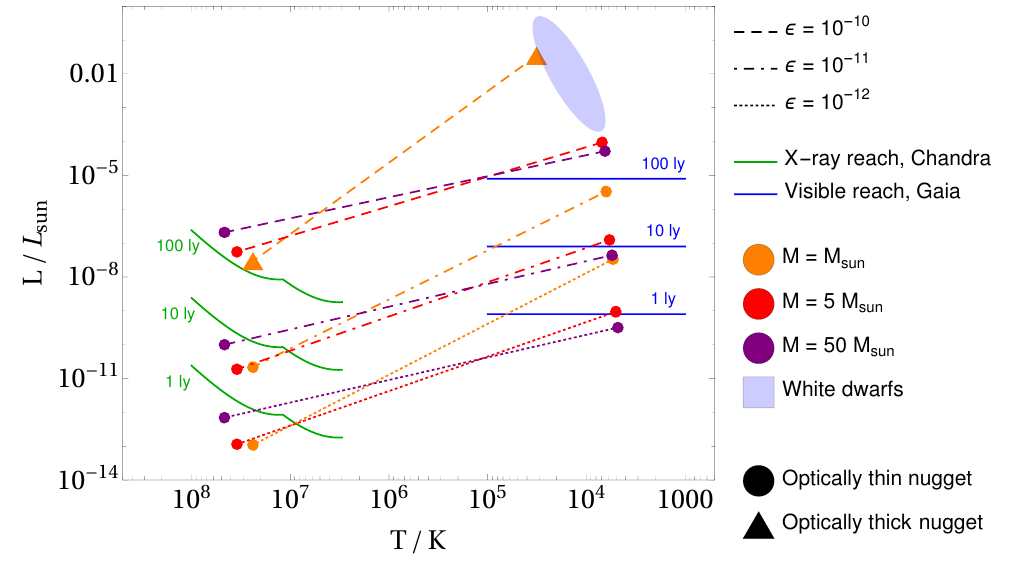
Figure 8 . A Hertzsprung-Russell diagram showing the dual signatures of our helium rich Mirror Star benchmarks. Labeling same as (cid:12)gure